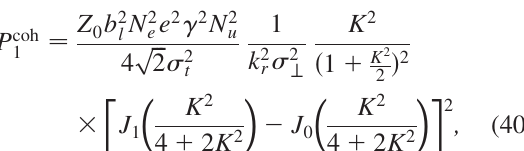
FIG. 8. (Color) Simulated bandwidth degradation for extremely . The simulation parameters are listed in small and large ! (cid:7) m Table I.